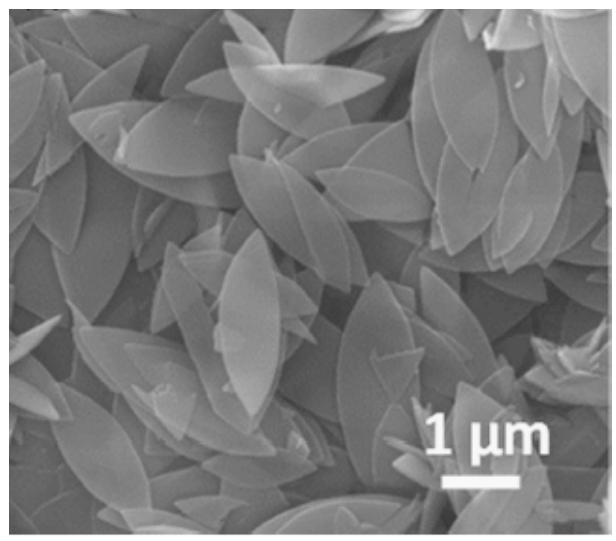
Figure 7. SEM image of the ZIF-L leaf-like nanoflakes [106].